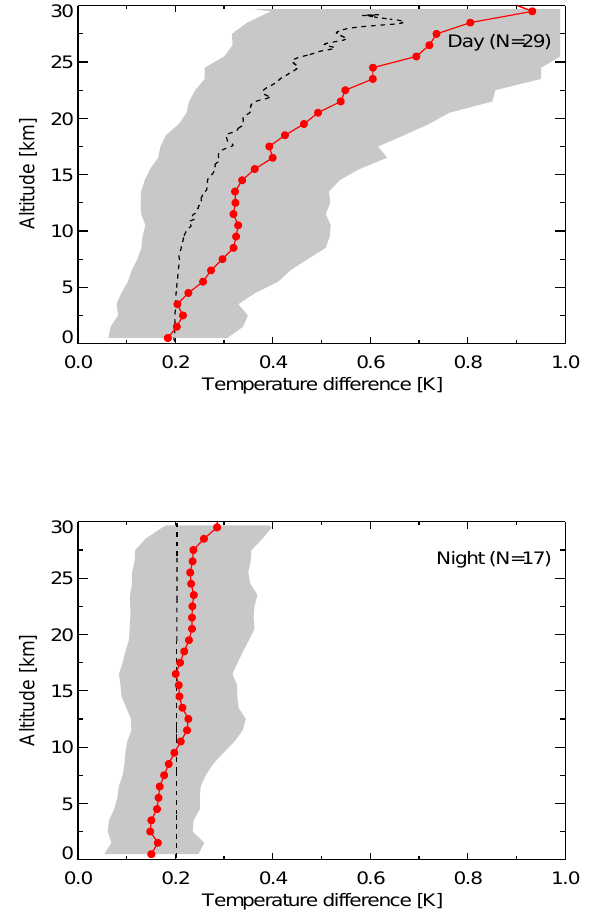
Figure 10. Uncertainty of the temperature measurements, deter- mined from 29 noon (top) and 17 midnight (bottom) RS92 dual launches performed in Lindenberg. The red line represents the mean of the difference of GRUAN temperature profiles; the black trace denotes the estimated uncertainty profile calculated for soundings performed on 17 September 2013; both traces are given for k = 2. The grey band represents the standard deviation of the measured temperature differences. Data are gridded in 1km wide bins. The maximum solar zenith angle during the noon sounding was 36.5 ◦ .